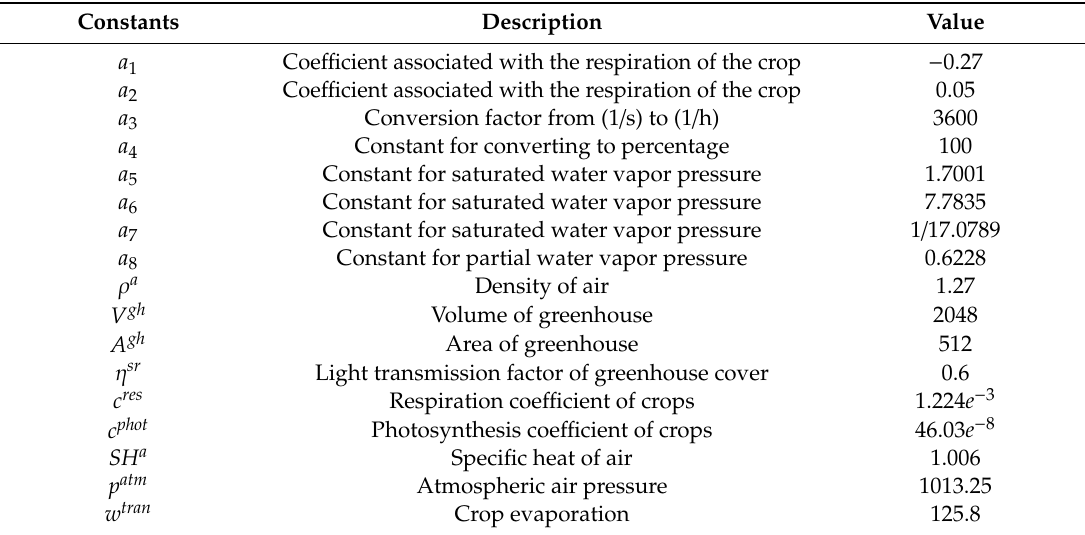
Table 5. Description and values of constants used in the problem formulation.